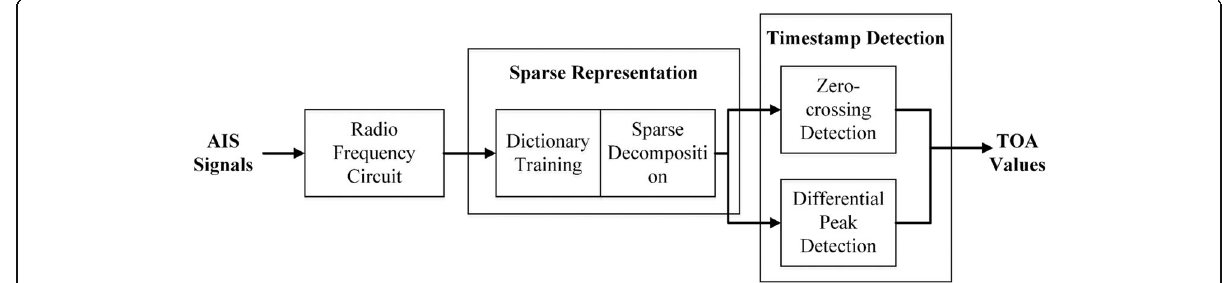
Fig. 7 Holographic detection of AIS real-time signals: the detailed system block diagram of holographic detection of AIS real-time